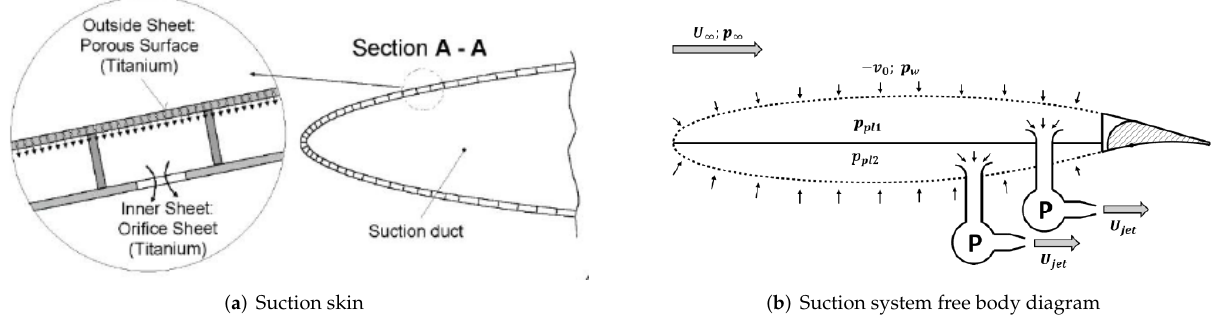
Figure 1. Schematic views of the active suction system. Adapted from